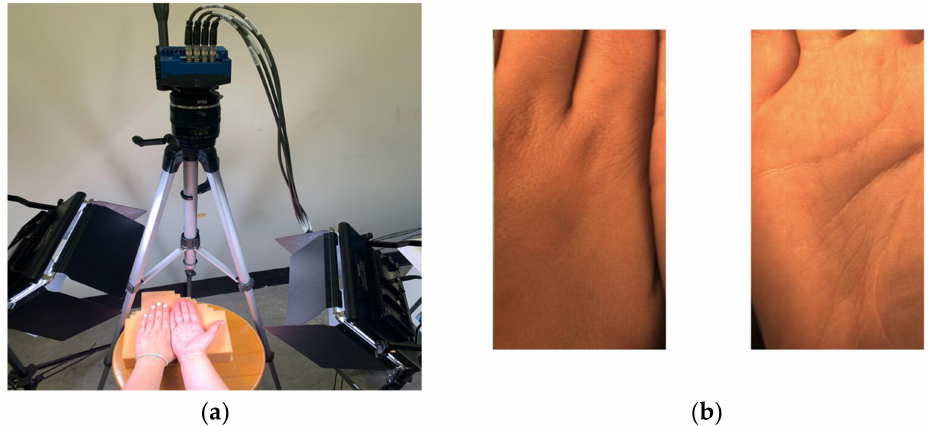
Figure 4. Subject undergoing signal acquisition ( a ) and subsequent division into left (non-glabrous) and right (glabrous) ( b